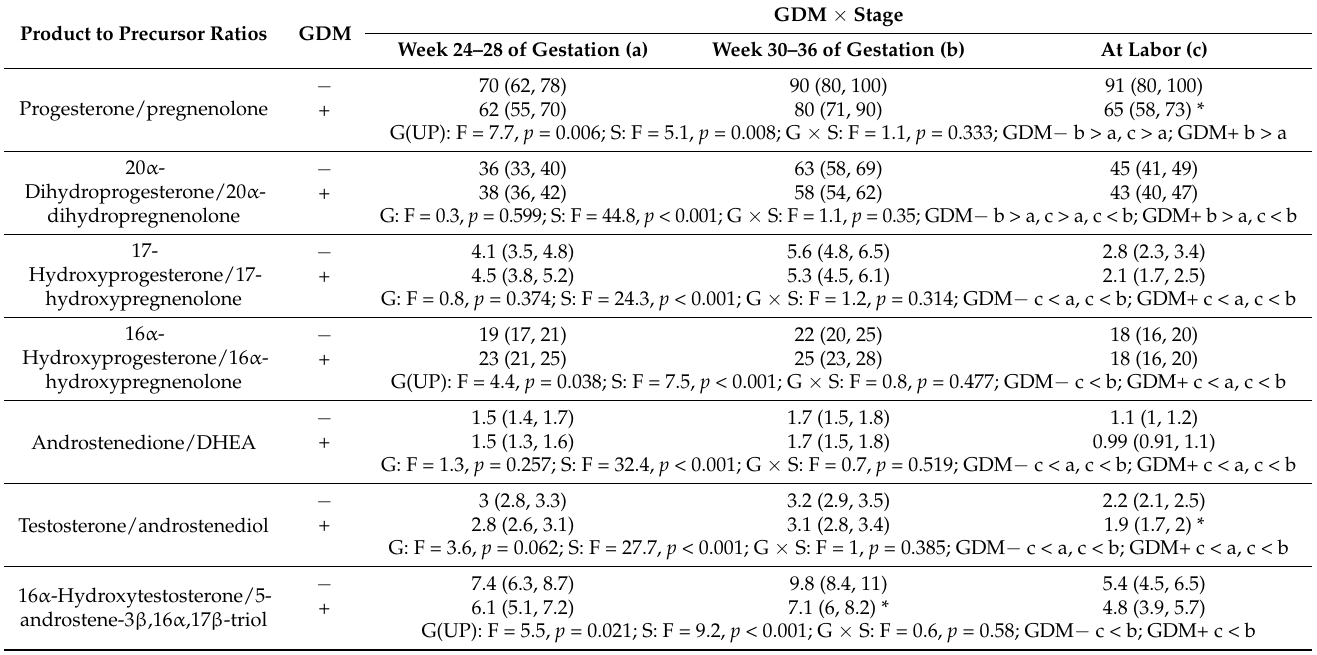
Table 7. Profiles of product to precursor ratios that may reflect HSD3Bs activities in the GDM − and GDM+ groups from week 24 of gestation to labor.